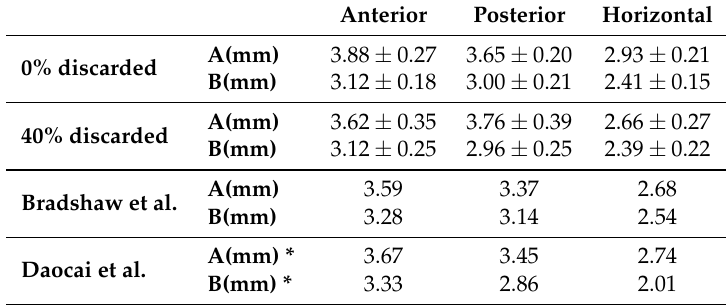
Table 4. Mean value and standard deviation of the fitting ellipse control parameters (major and minor ellipse axis) for the three different SCs. The values presented correspond to two cases: retaining the whole duct and using as rejection threshold the percentile 40%. We include also the results of Bradshaw et al. [12] and Daocai et al. [24] for comparison.